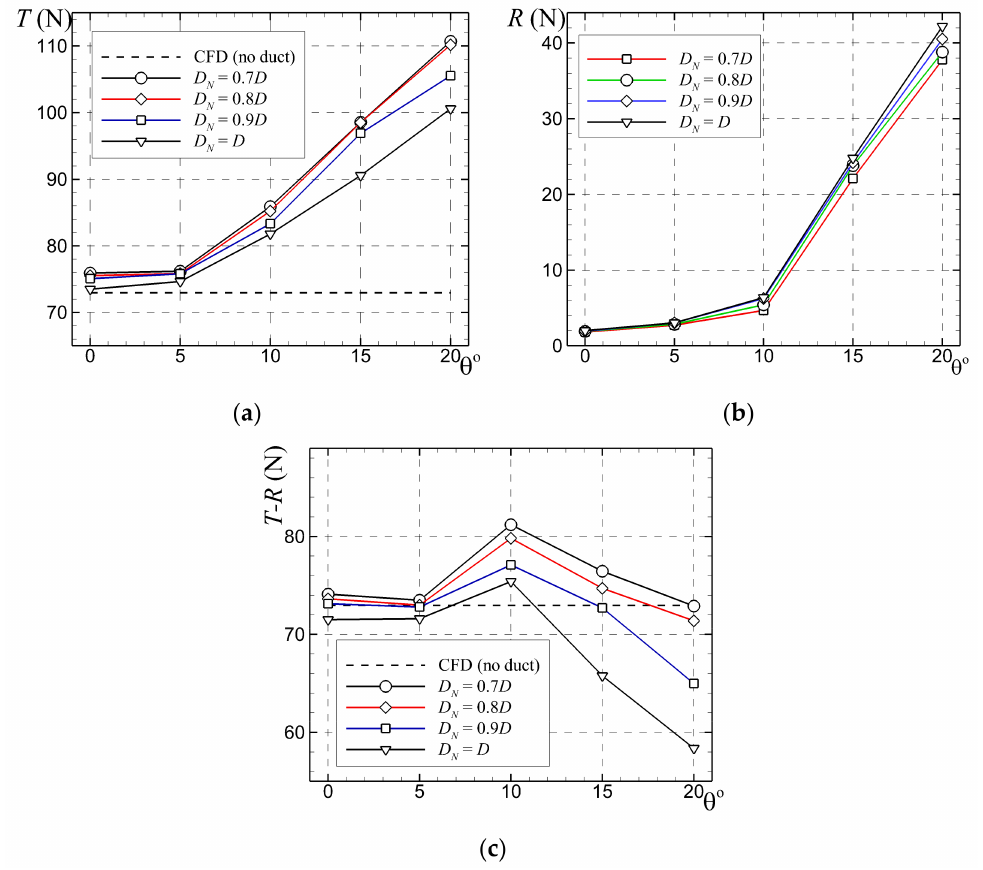
Figure 20. Comparison of axial forces computed in the nozzle-propeller cases: ( a ) propeller thrust, ( b ) nozzle drag, ( c ) total axial